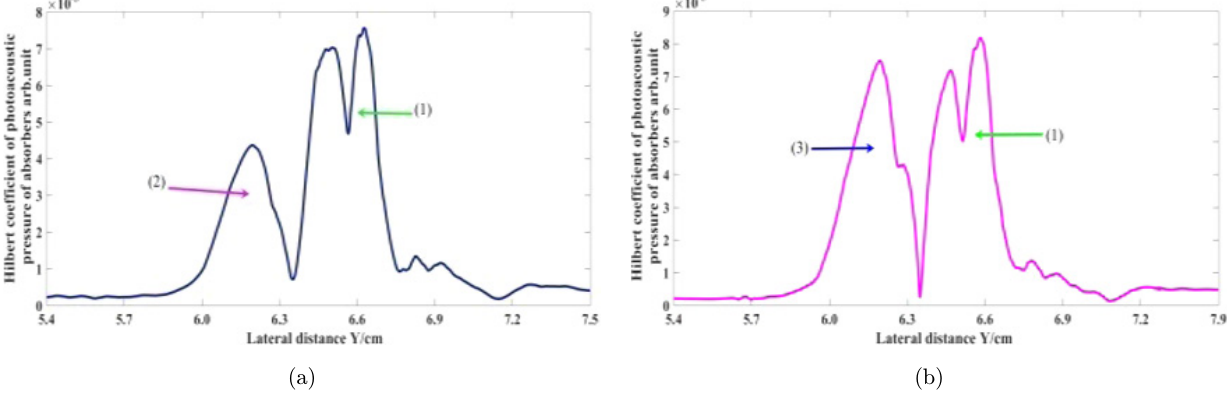
Fig. 5. PAI of absorbers with di®erent absorption coe±cient. (a) Hilbert transform results of photoacoustic signals of absorbers (2) and (1); (b) Hilbert transform results of photoacoustic signals of absorbers (3) and (1); (c) Hilbert transform results of photoacoustic signals of absorbers (4) and (1); (d) Hilbert transform results of photoacoustic signals of absorbers (5) and (1); (e) Hilbert transform results of photoacoustic signals of absorbers (6) and (1); (f) Two-dimensional PAI of absorbers (1) – (6); (g) Three-dimensional photoacoustic signal amplitude imaging of absorbers (1) – (6); (h) The relationship between the ratio of absorption coe±cient and the ratio of photoacoustic pressure for absorbers to absorber